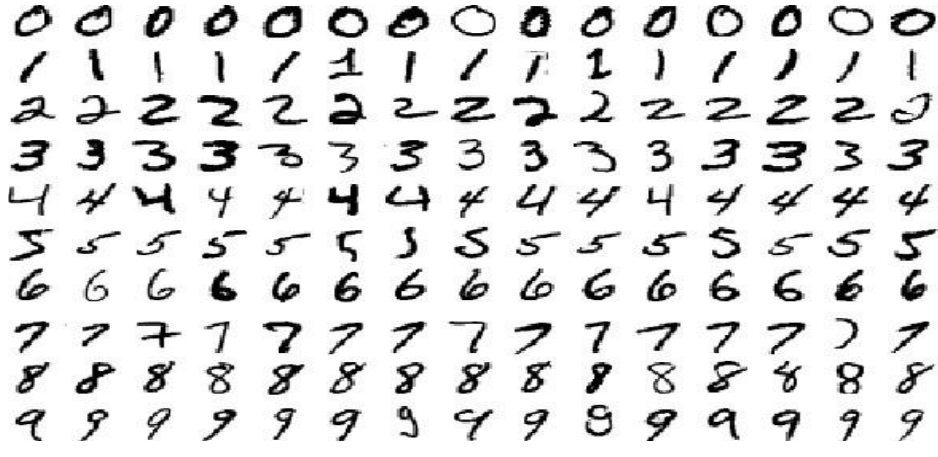
Figure 5. An illustration of the MNIST